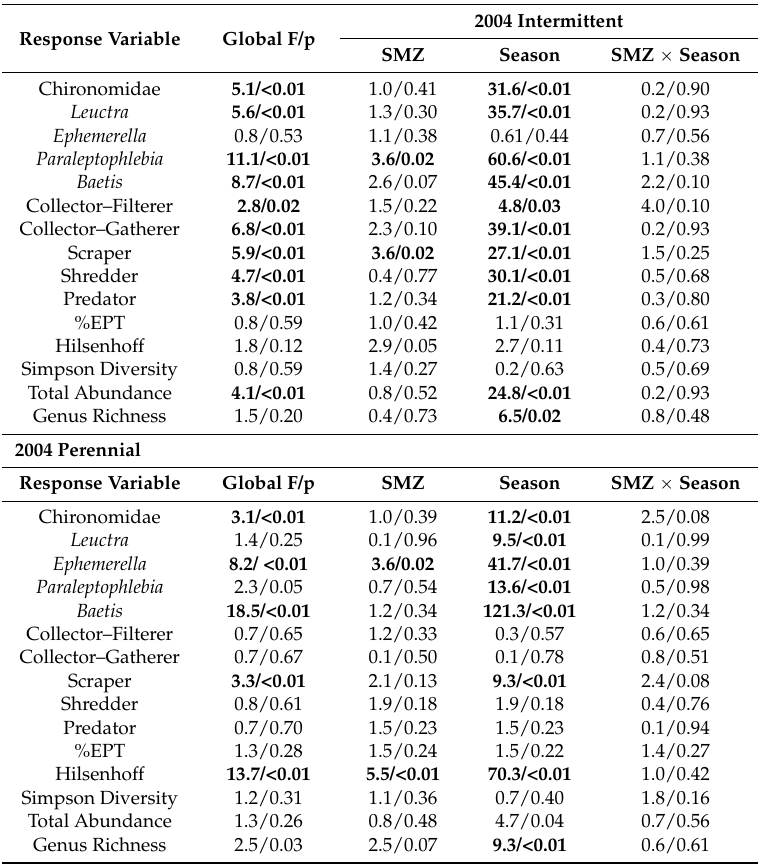
Table 2. Pre-harvest effects * of SMZ treatment, season, and their interaction on benthic macroinvertebrate abundance at Robinson Forest, Kentucky